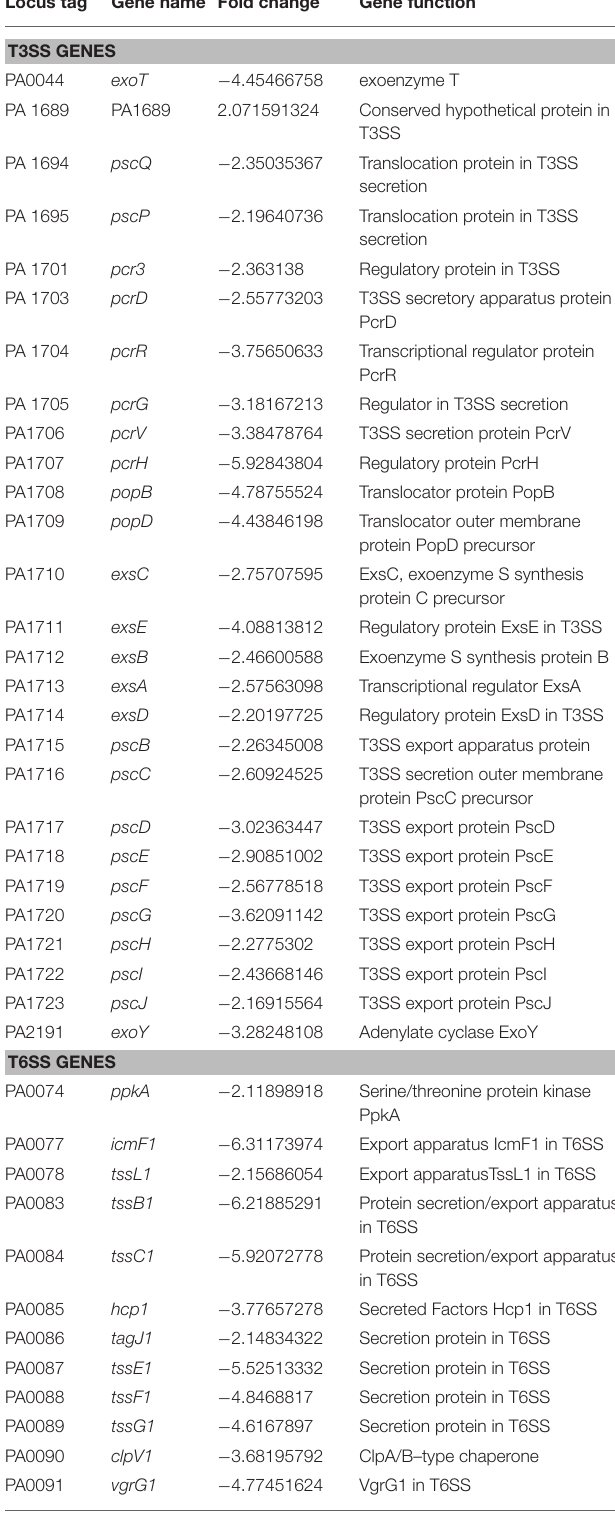
TABLE 1 | Genes with altered expression in 1 gshA 1 gshB when compared to parental wild-type PAO1. Locus tag Gene name Fold